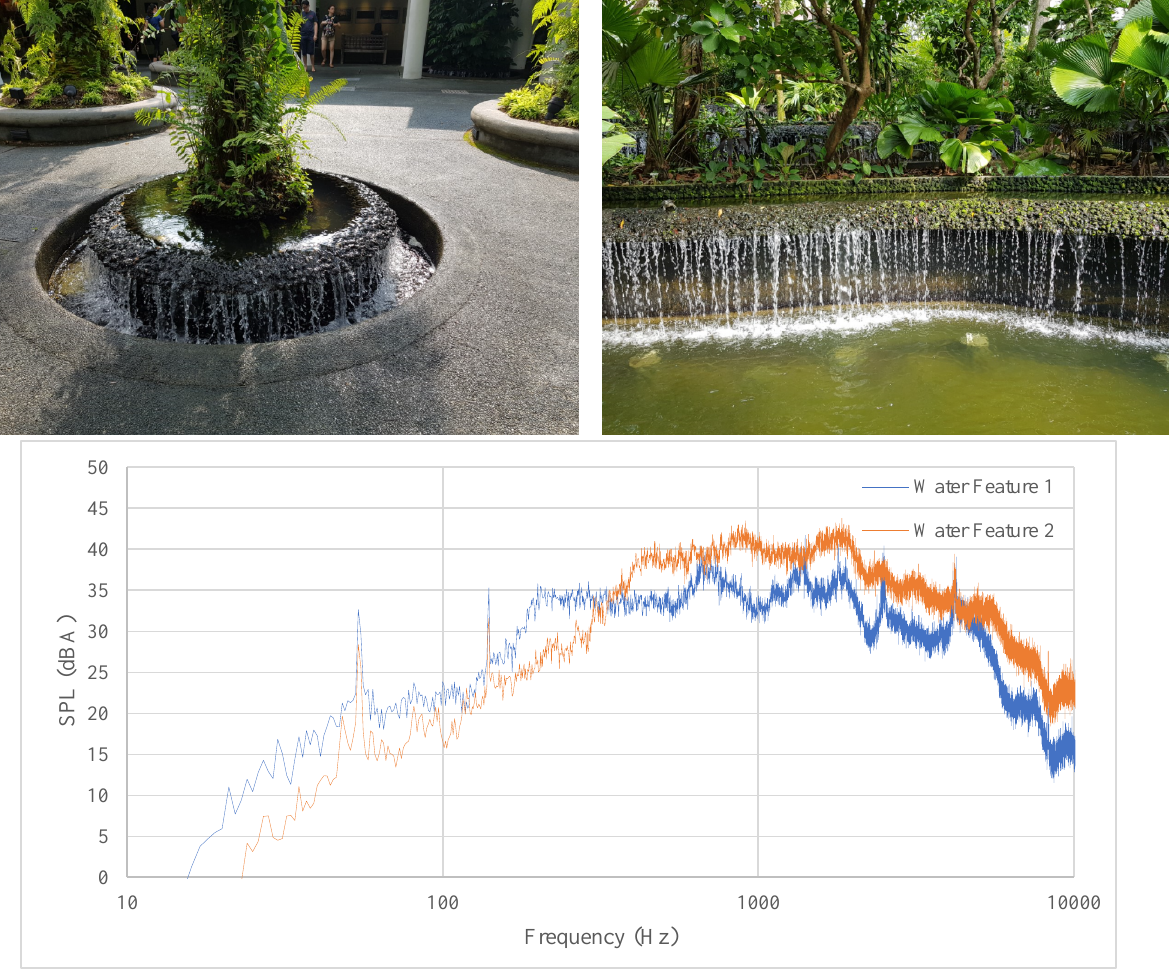
Figure 7: Two water features at the central region near Nassim Gate and their average frequency spectrums in